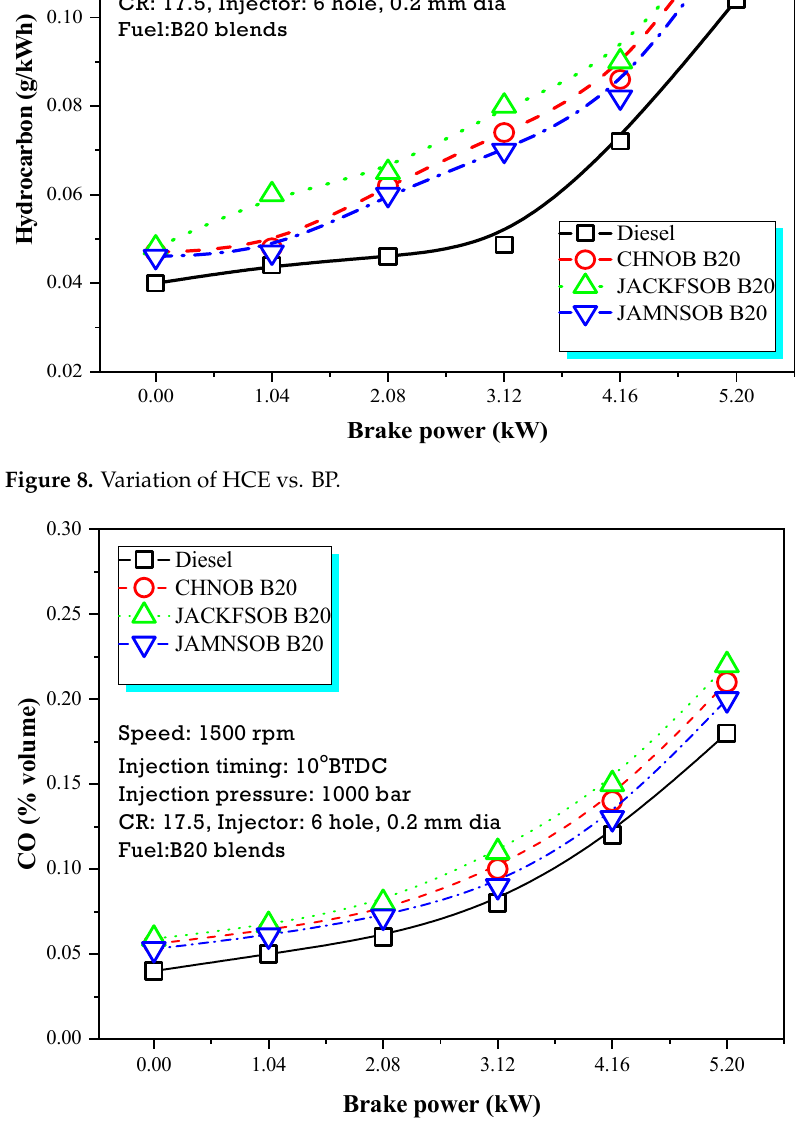
Figure 9. Variation of COE vs. BP.